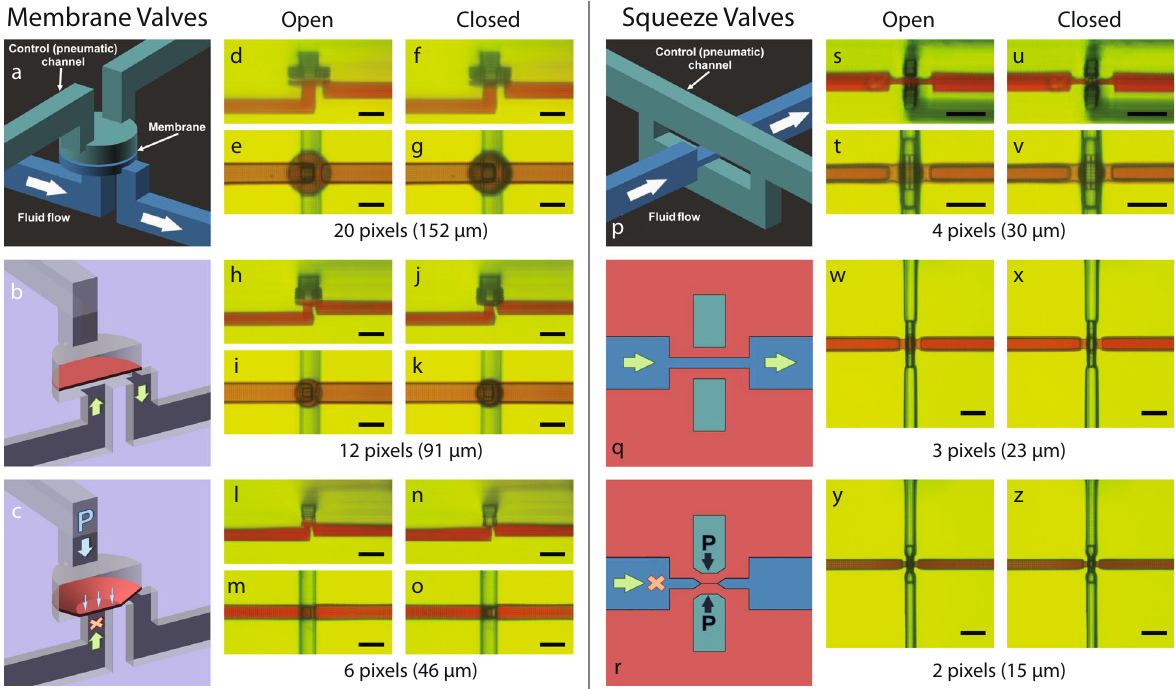
Fig. 1 3D printed membrane valves and squeeze valves. a Schematic diagram of membrane valve geometry with cut-away schematics showing a membrane valve in ( b ) open and ( c ) closed states depending on pneumatic pressure applied through the control channel. d – o Side- and top-view microscope images of ( d – g ) 20 pixel, ( h – k ) 12 pixel, and ( l – o ) 6 pixel diameter valves in their open and closed states. p Schematic diagram of squeeze valve geometry with cross-section diagrams (rotated 90 ∘ ) showing a squeeze valve in ( q ) open and ( r ) closed states depending on pneumatic pressure applied through the control channel, which squeezes together to close the fl ow channel. s – z Microscope images of ( s – v ) 4 × 4 pixel (side- and top-view), ( w , x ) 3 × 3 pixel (top-view), and ( y , z ) 2 × 2 pixel (top-view) valves in their open and closed states. All scale bars are 100 μ